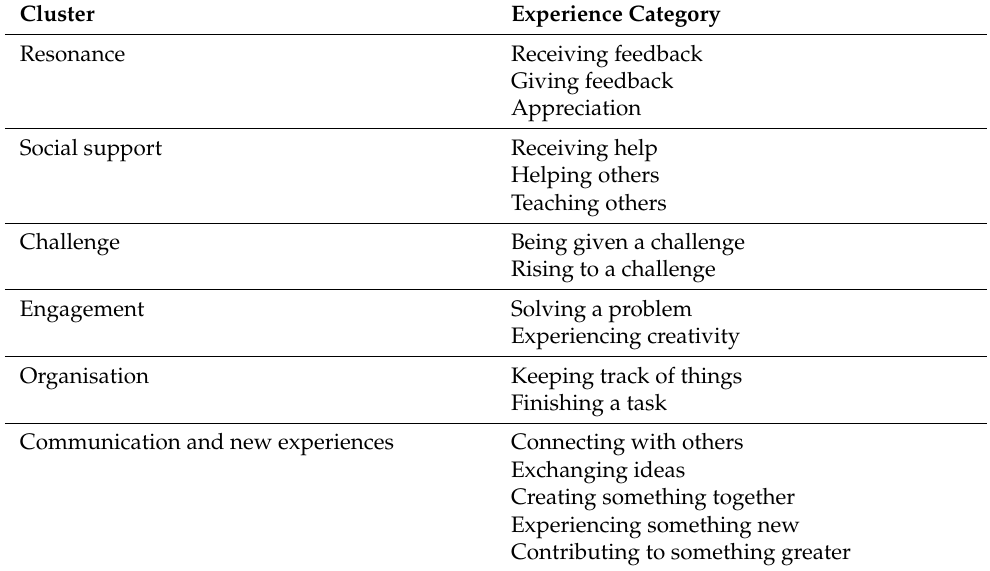
Table 3. Experience categories for the work context